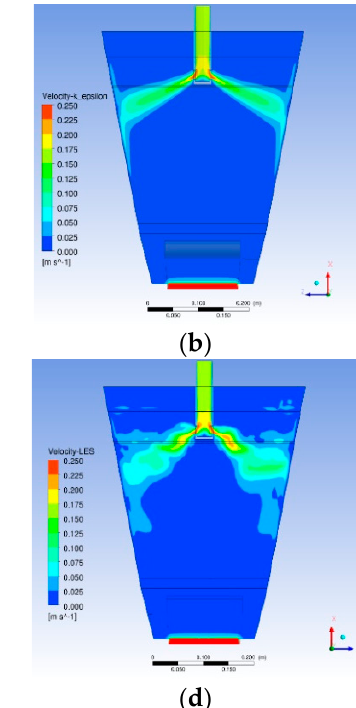
Figure 3. Effect of turbulence model on the predicted flow pattern. ( a ) Water model experiment, ( b ) realizable k-epsilon model, ( c ) k-omega SST model, ( d ) LES model.